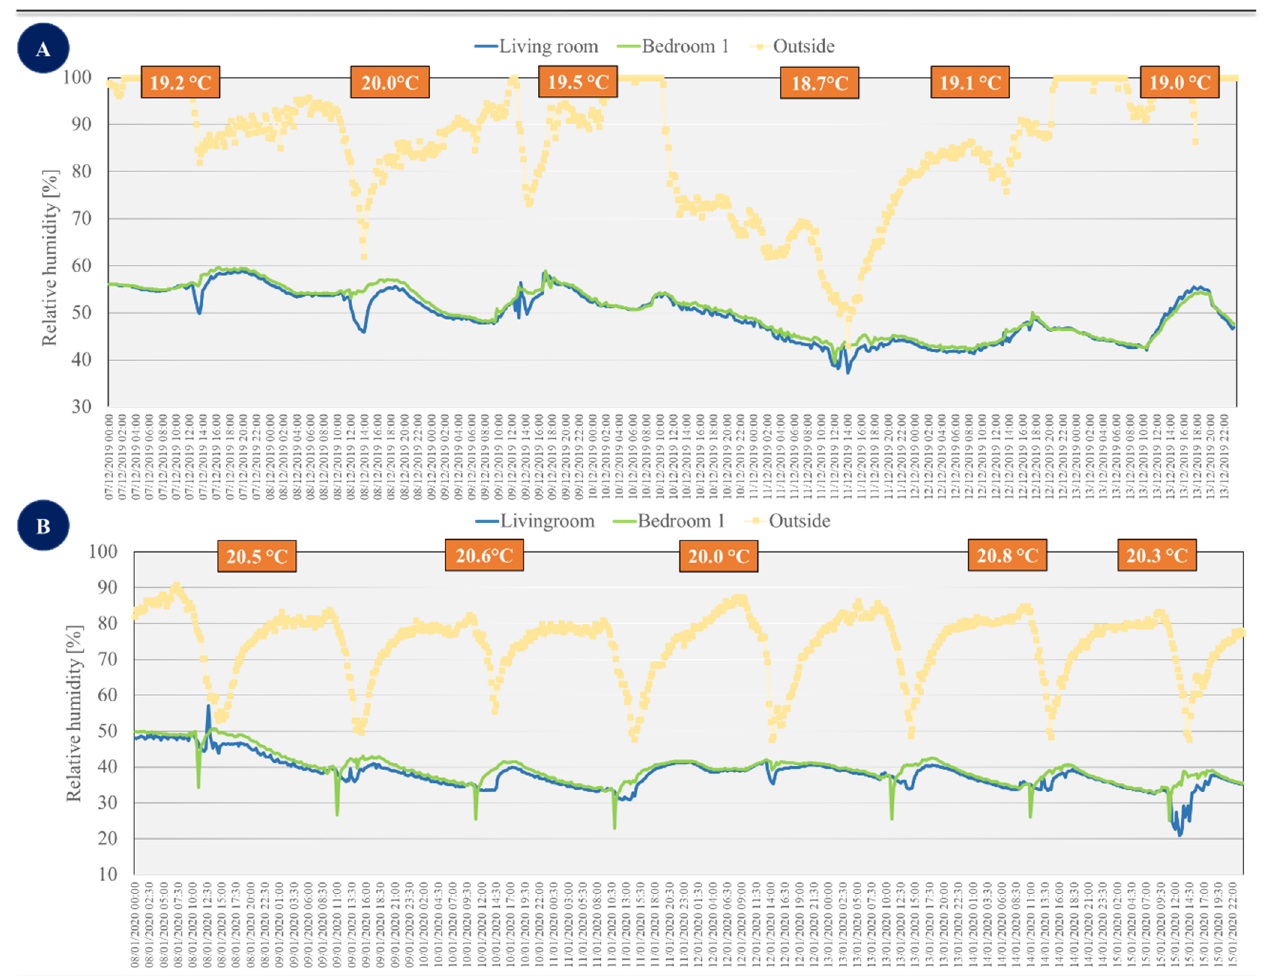
Figure 2. Relative humidity trend: ( A ) setpoint lower that 20 °C and ( B ) upper 20